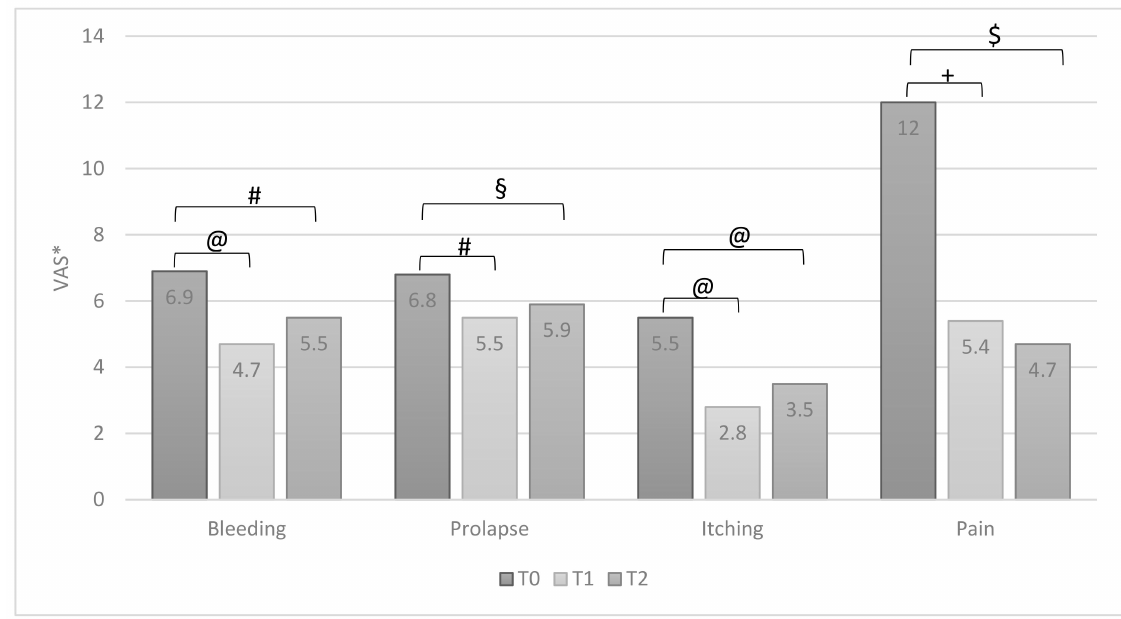
Figure 5. Group B: patients’ symptoms at T0, T1 and T2 (ANOVA test, values are means). * VAS: Visual Analogue Scale, at 10-points, except for pain, at 100-points. @ p = 0.0001; # p = 0.001; § p = 0.023; + p = 0.03; $ p =